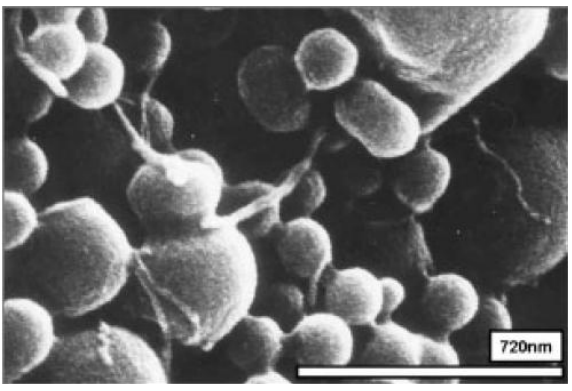
Figure 5. SEM image of MWNT/PMMA particles (reprinted with permission from [34], Copyright 2005 Wiley-VCH).